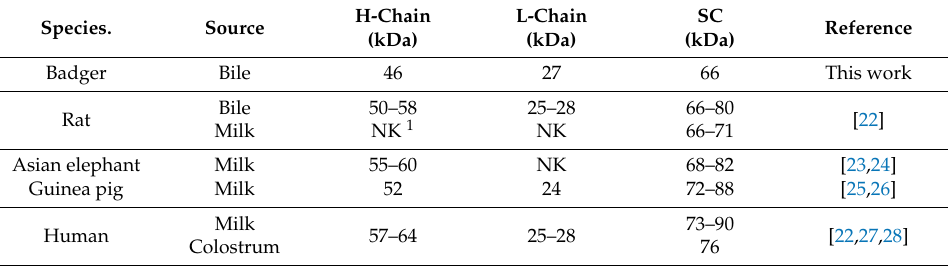
Table 1. Estimated molecular weights of badger sIgA components compared with those of selected other species for which data could be